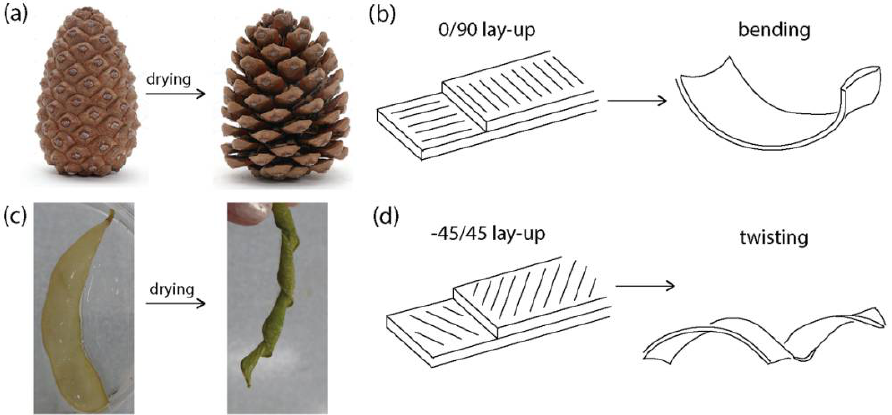
Figure 1. Principle of bioinspired self-shaping. ( a ) Pictures of a pinecone before and after morphing upon drying; ( b ) Schematics of the 0/90 layup architecture in the pinecone scales, leading to bending; ( c ) Pictures of an edamame seed pod before and after morphing upon drying; ( d ) Schematics of the − 45/45 layup architecture in the seedpod, leading to twisting.